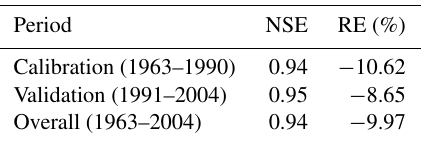
Table 4. Evaluation metrics, Nash–Sutcliffe efficiency, and relative error of the SWAT model on a monthly